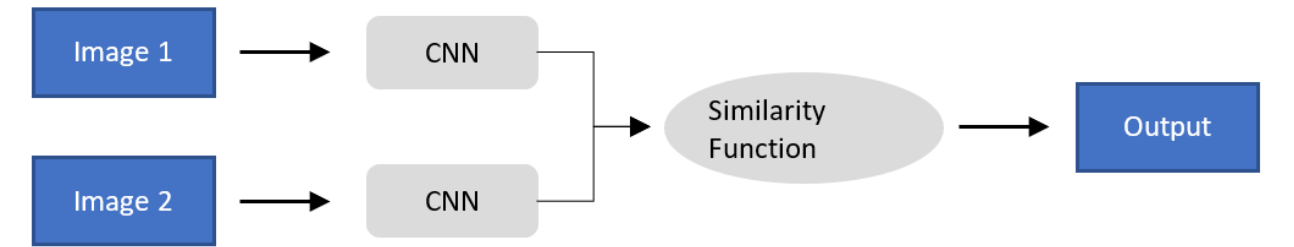
Figure 1. Siamese neural network architecture using convolutional neural networks (CNN).